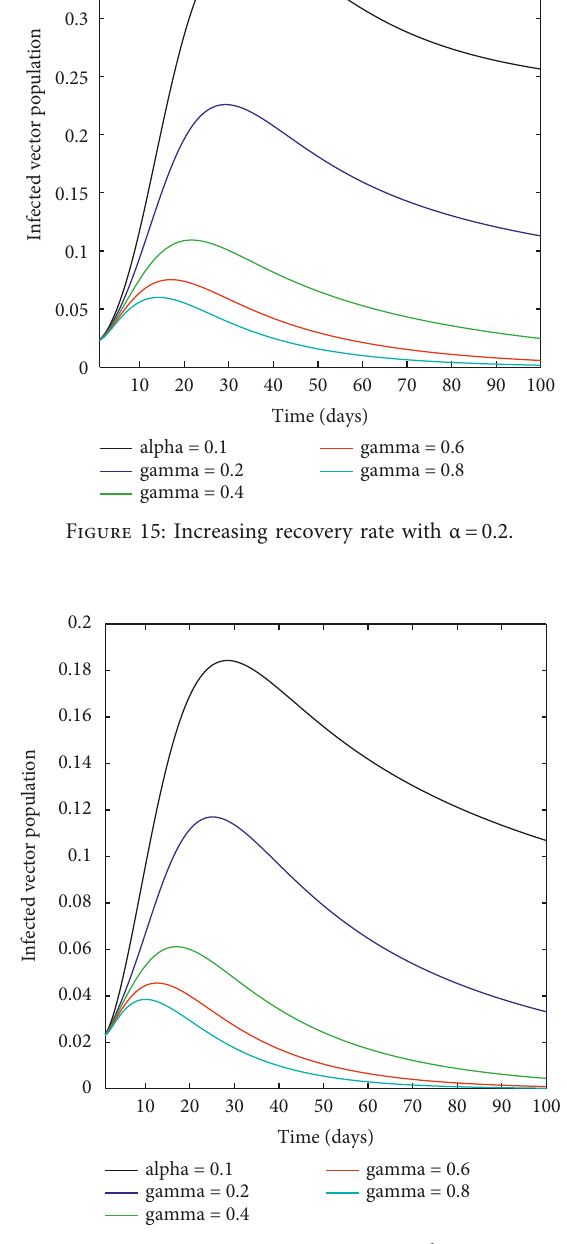
Figure 14: Increasing recovery rate with α � 0.8.